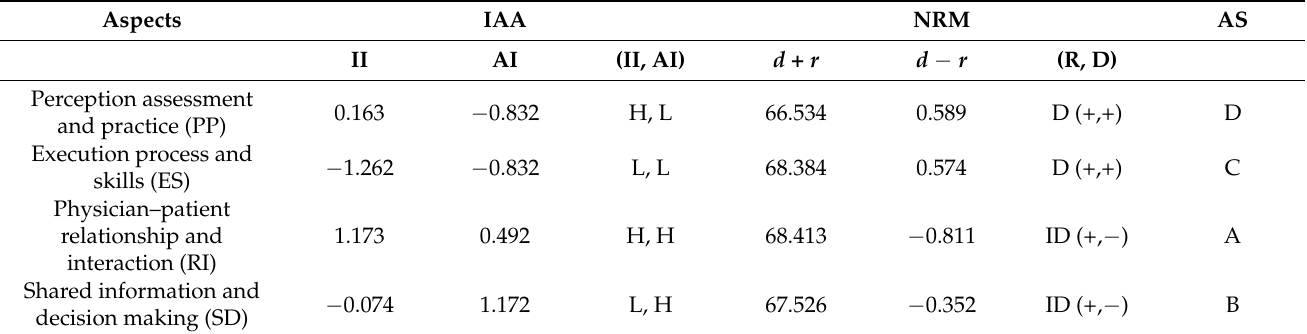
Table 6. The adoption strategy of SDM competency development for attending physicians.